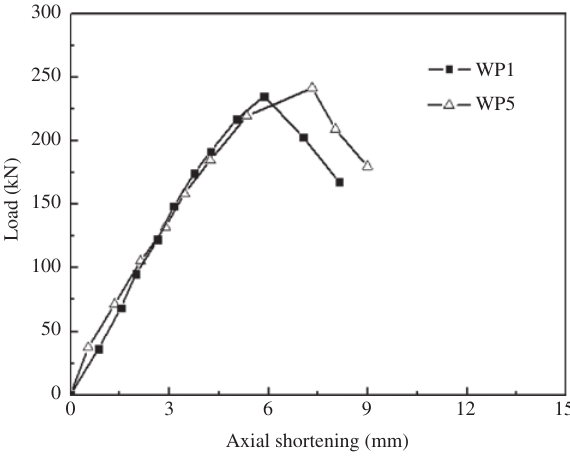
= 2.4 mm, t = 2.4 mm). w s